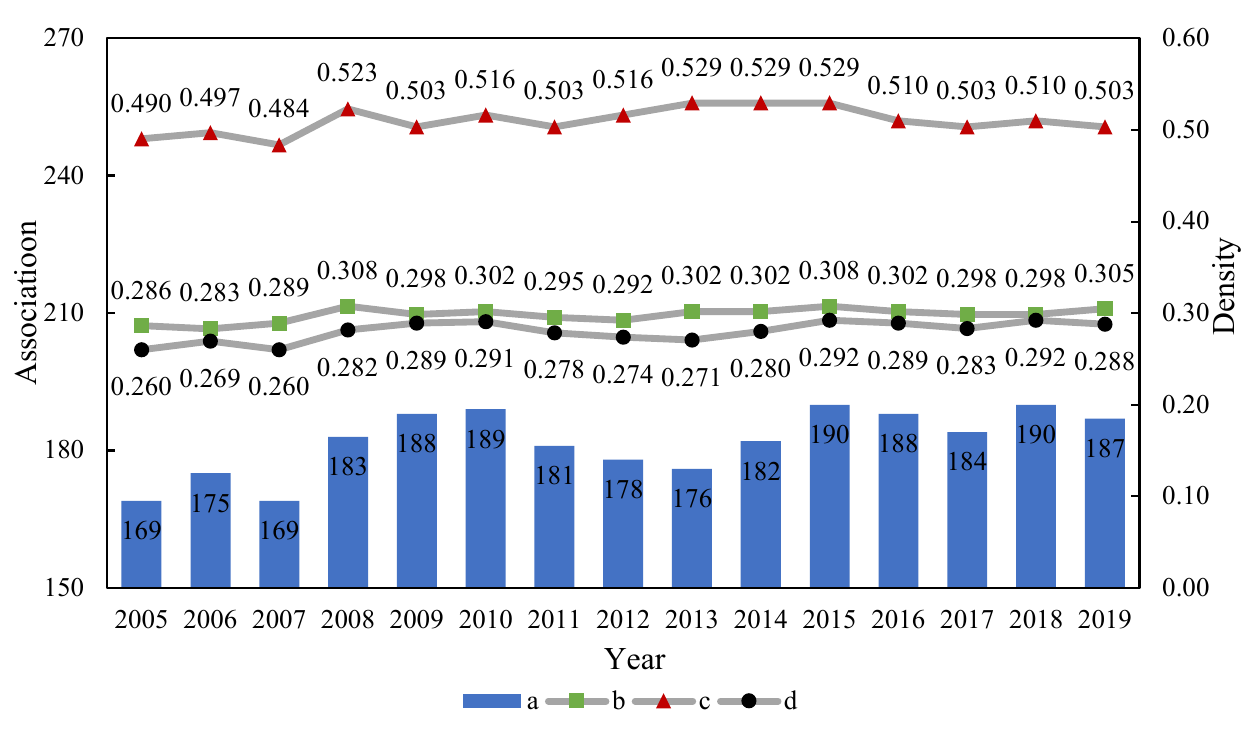
Figure 5. The associations and densities of city networks in the YRDUA.